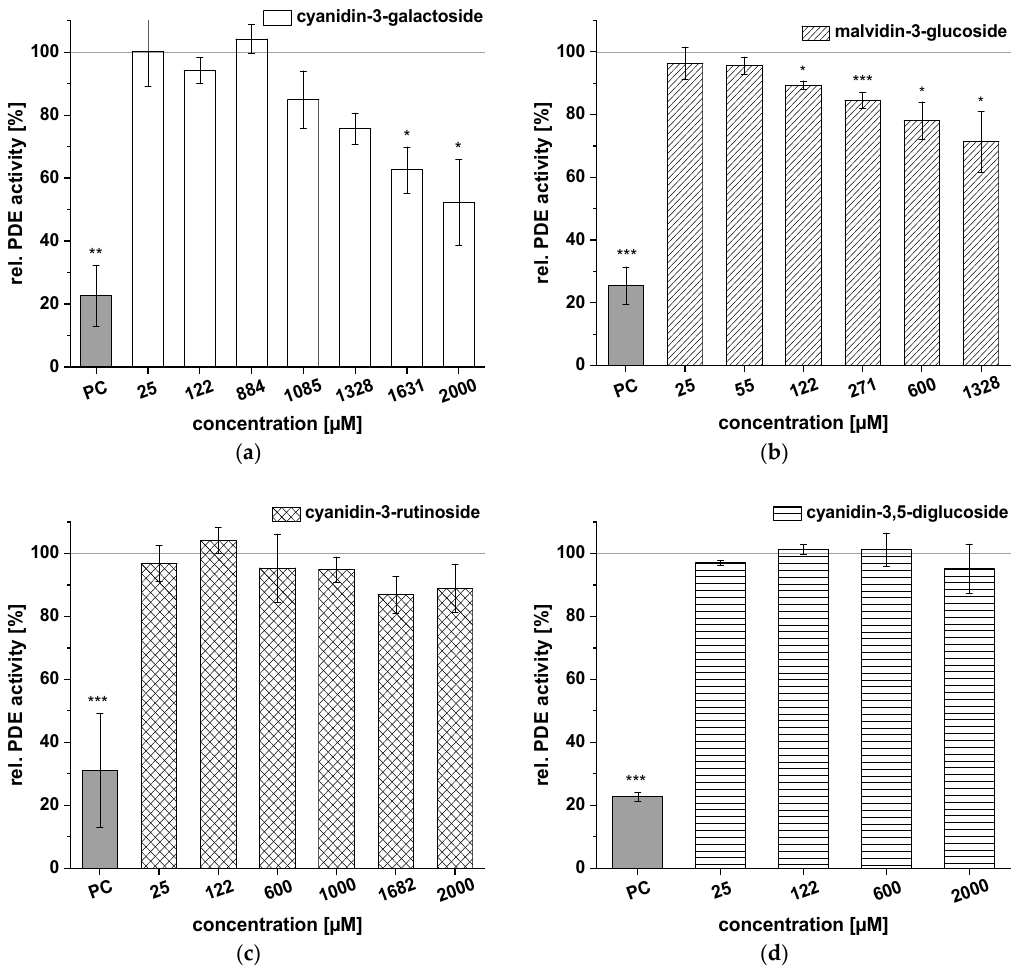
Figure 6. Results for tests of cAMP-specific phosphodiesterase (PDE) activity after incubation with cyanidin-3-galactoside ( a ), malvidin-3-glucoside ( b ), cyanidin-3-rutinoside ( c ), and cyanidin-3,5-diglucoside ( d ). Positive control (PC) was caffeine. Data are expressed as relative (rel.) PDE activity (in percentage of solvent control) as mean ± standard deviation of three or four independent experiments. The significance of differences between sample and solvent control (100%) was assessed using Student’s t -test. * p < 0.05; ** p < 0.01; *** p < 0.001.